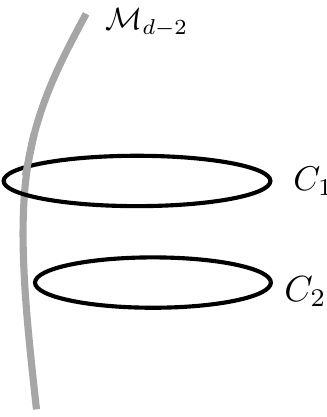
Figure 5: Example of linking surfaces in d = 3; here C − 2 , but C 2 does M d